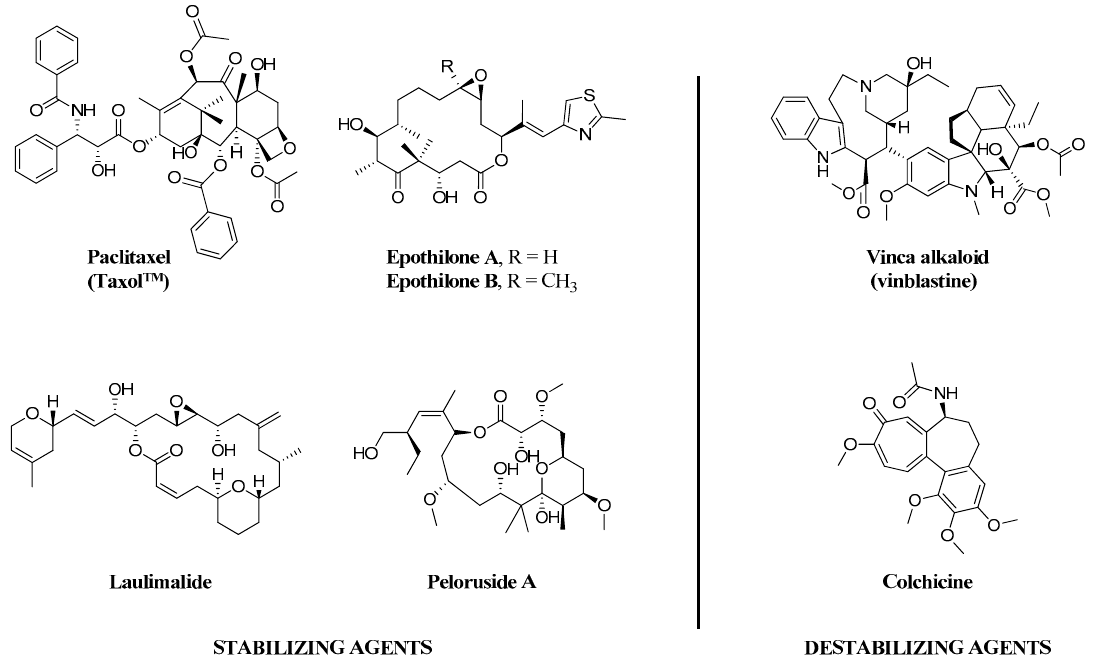
Figure 1. Chemical structures of representative natural products of microtubule stabilizing (MSA) and destabilizing agents (MDA).